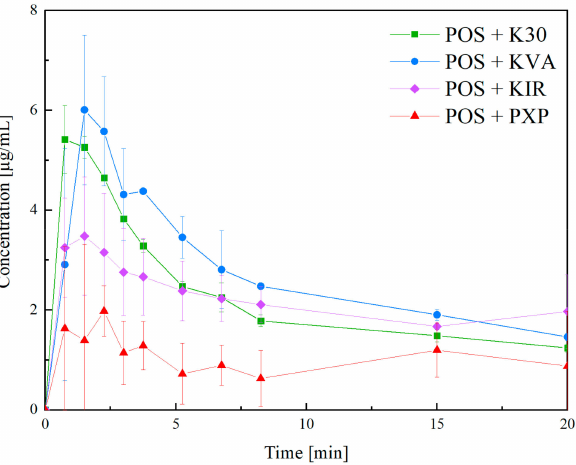
Figure 9. The dissolution profiles of POS + K30, POS + KVA, POS + KIR, and POS + PXP extrudates. Table 3. Comparison of all properties investigated in the paper: (a) appearance of melting